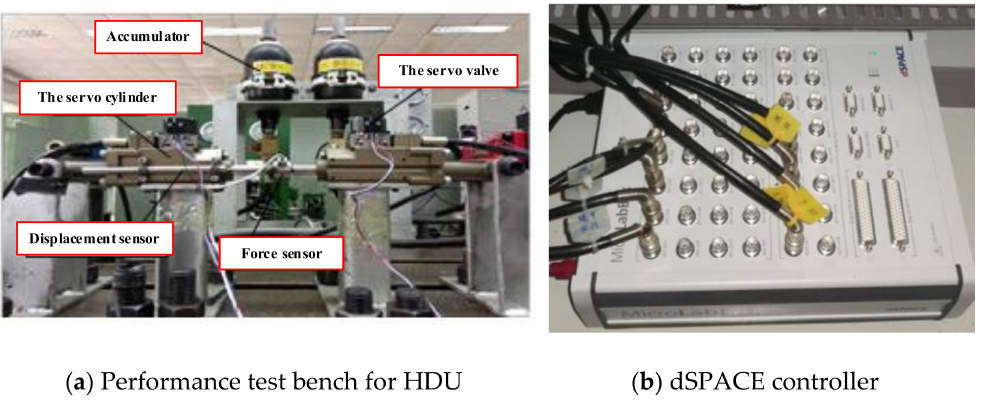
Figure 12. Photos of the experimental